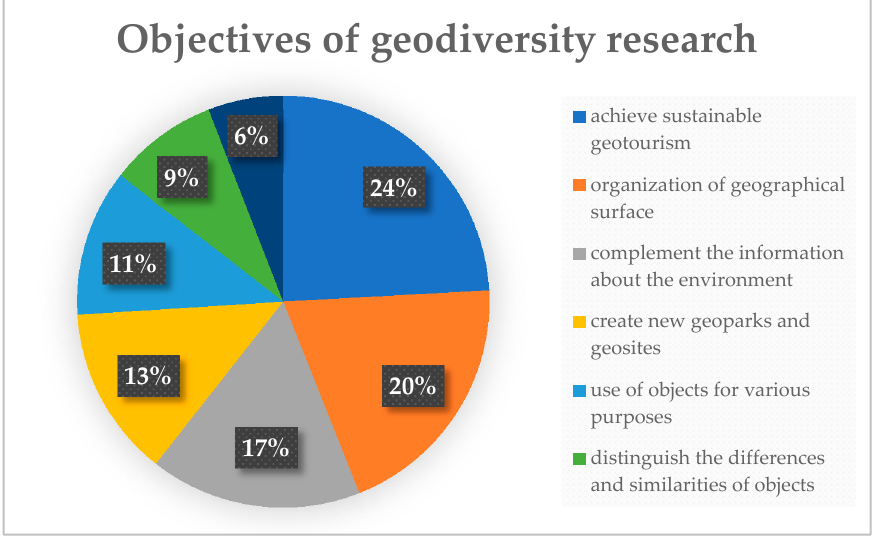
Figure 2. The most common scientific reasons for geodiversity research.